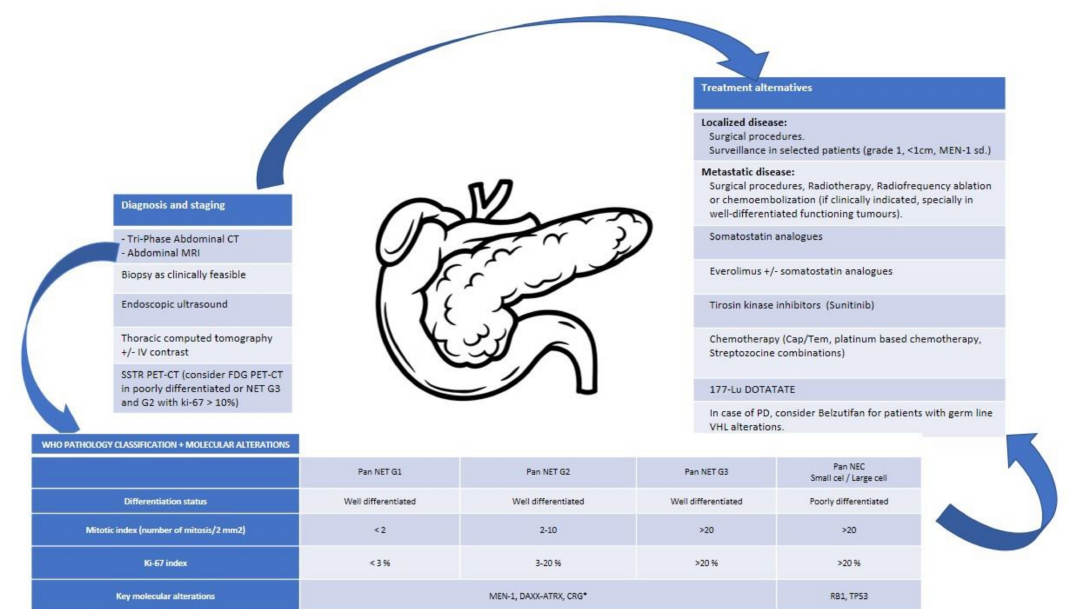
Figure 4. Integrative algorithm of current management in Pan NENs.* No specific data for NET-G3 available. Cap/Tem, capecitabine/Temozolomide; CRG, cromatin remodeling genes; CT, computed tomography; FDG, fluorodeoxyglucose; G, grade; IV, intravenous; MRI, magnetic resonance imaging; NEC, neuroendocrine carcinoma; NET, neuroendocrine tumour; Pan., pancreatic; PD, progressive disease; PET-CT, positron emission tomography-computed tomography; sd., syndrome; SSTR, so- matostatin receptors; VHL, Von Hippel-Lindau [98].